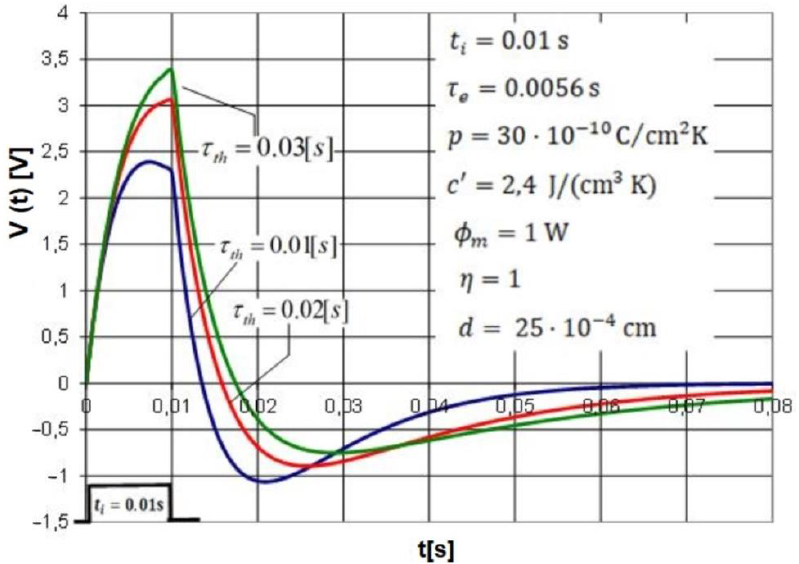
Figure 2. Voltage response V ( t ) of PVDF pyroelectric detector to rectangular radiation pulse of duration t i = 0.01 s for different values of thermal time constant τ th . The PVDF detector voltage response plots colored blue, red and green are determined for the thermal time constants of τ th = 0.01 s, τ th = 0.02 s and τ th = 0.03 s, respectively. Other parameters of the detector are listed in the figure.